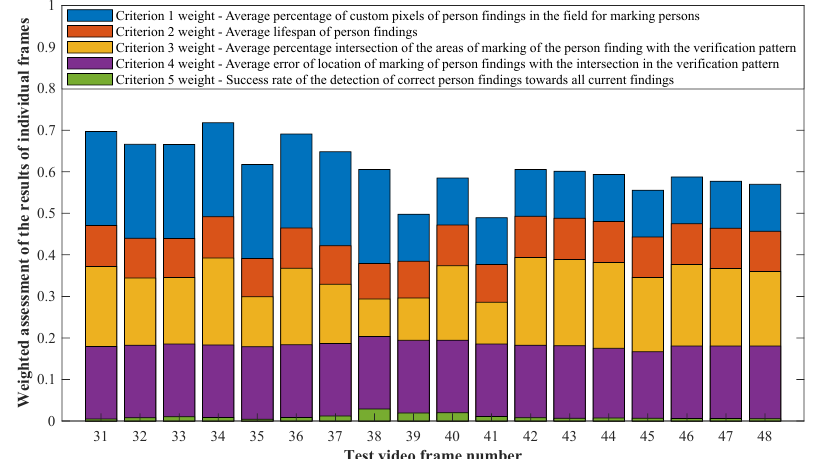
Figure 26. Distribution of the individual criterion weights in the practical result of the video section.